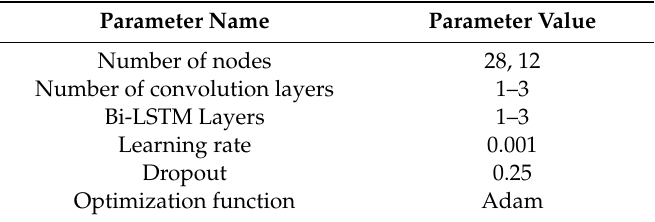
Table 4. Parameter settings of the named-entity recognition